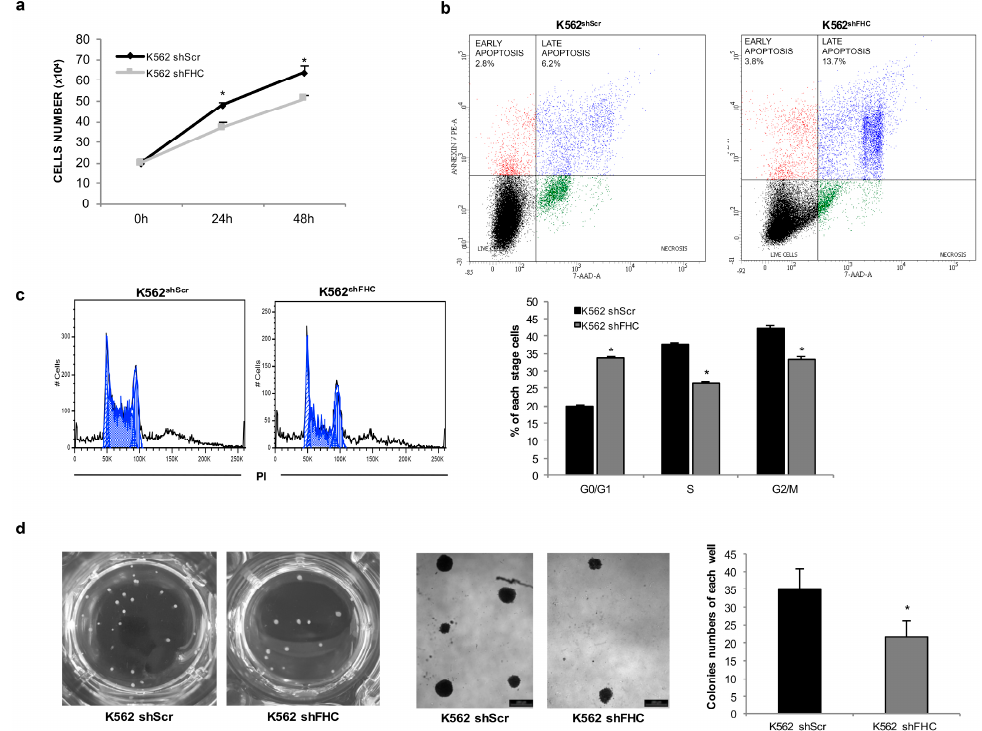
Figure 3. FHC silencing suppresses the proliferative rate and the clonogenic potential of K562 cells.( a ) Direct cell counting of K562 shScr and K562 shFHC at 0, 24 and 48 h; ( b )Apoptosis analysis in K562 shScr and K562 shFHC using Annexin V/7-AAD double staining. The reported plots are representative of two independent experiments; ( c ) Representative flow cytometry plots of cell cycle analysis in K562 shScr and K562 shFHC with statistics on the right side. All data represent mean ± SD ( n = 3). * p < 0.05 compared with K562 shScr cells; ( d ) Representative microscopy images and statistics of colony formation assay in K562 shScr and K562 shFHC ; colonies were observed and counted in each well of 12-well plate. Scale bar: 200µm. All data represent mean ± SD ( n = 3). * p < 0.05 compared with K562 shScr cells.